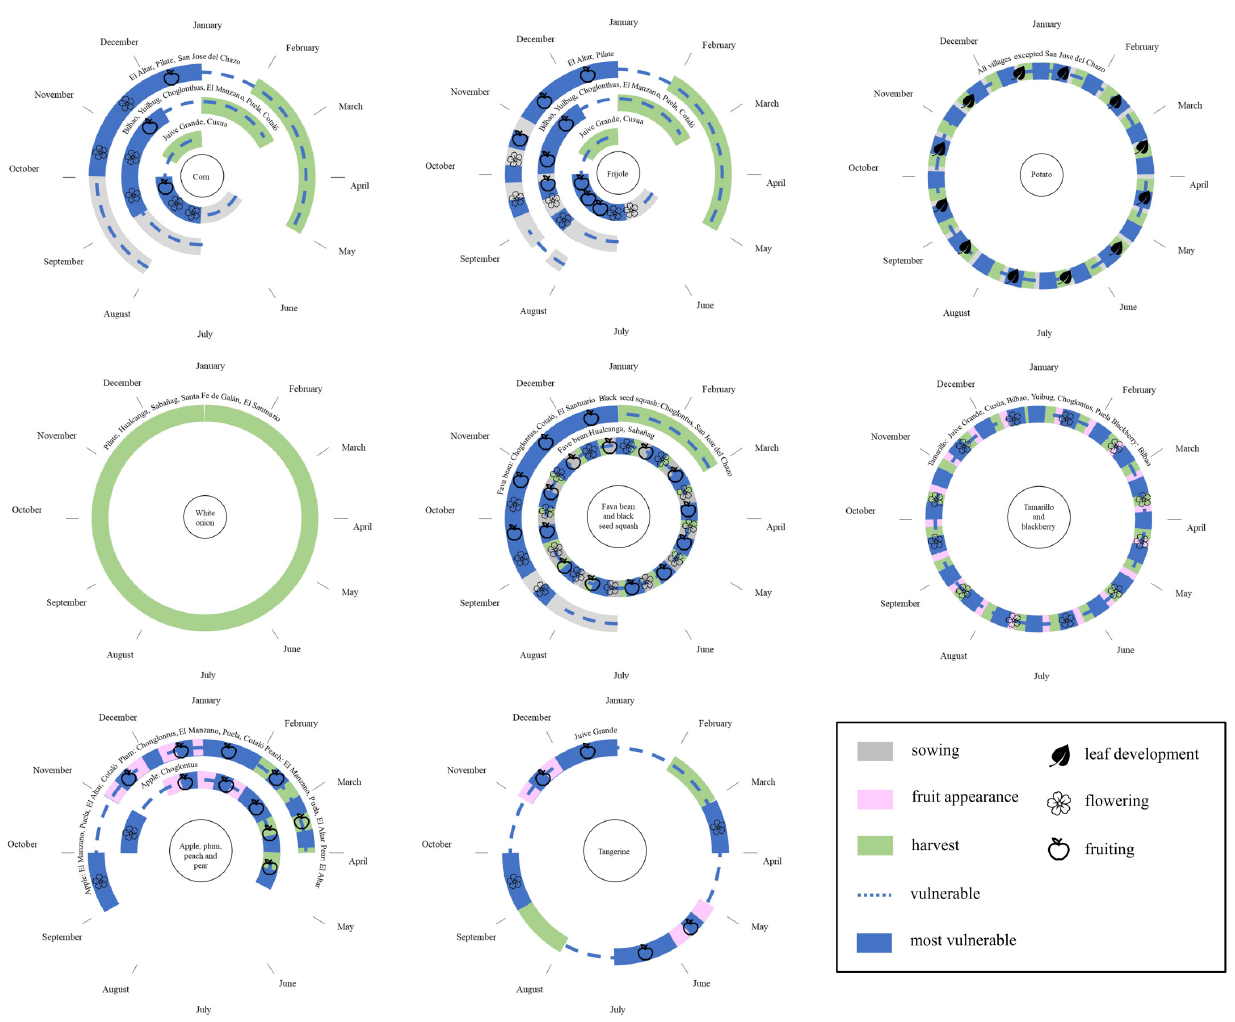
Figure 2: Illustration of the crop calendars for the main crops cultivated in the 15 villages surveyed in 2014. Each- crop specific calendar shows the period of sowing (annual plants), fruit appearance (fruit trees), and harvest. The period corresponding to the plant development stage(s) (i.e. leaf production, flowering, and fruit/grain formation) most vulnerable to tephra fall is indicated in